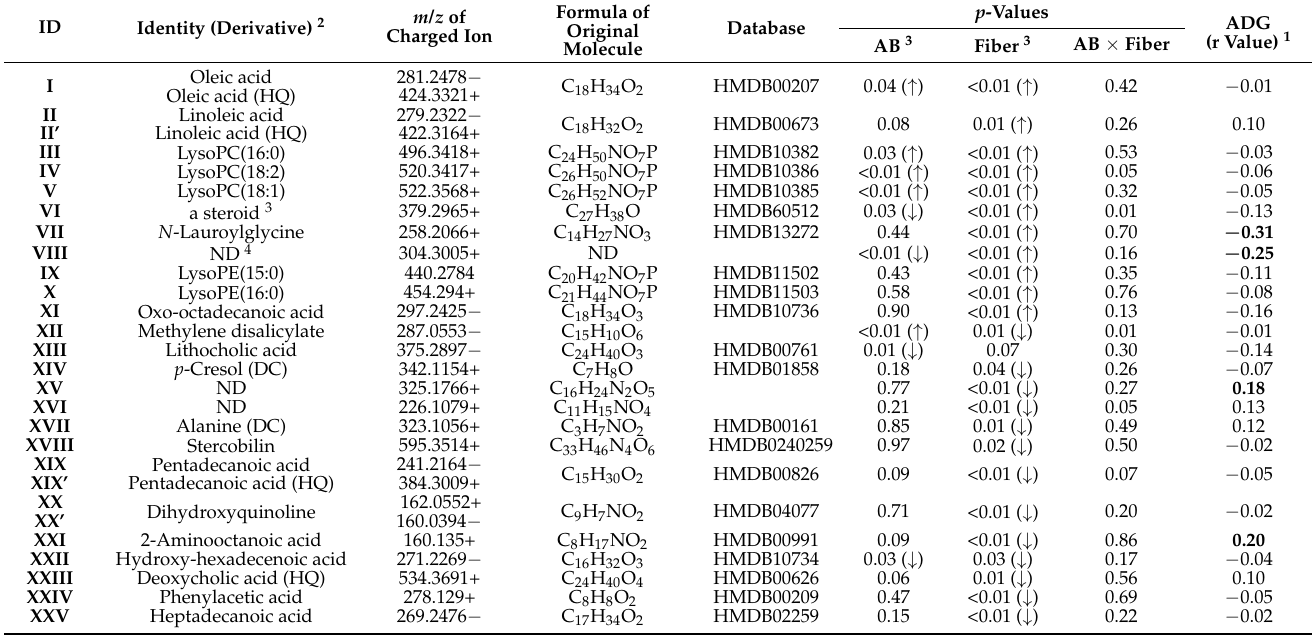
XV and XVI (Figure 5E,F). The correlations between metabolite markers and growth were also identified (Table 3). Metabolite XV and 2-aminooctanoic acid (XXI) were positively correlated with ADG, with r = 0.18 and 0.20, respectively, while N -lauroylglycine (VII) and unknown metabolite (VIII) were negatively correlated with ADG, with r = − 0.31 and − 0.25, respectively. Table 3. Fecal metabolites affected by high-fiber and antibiotic treatments.